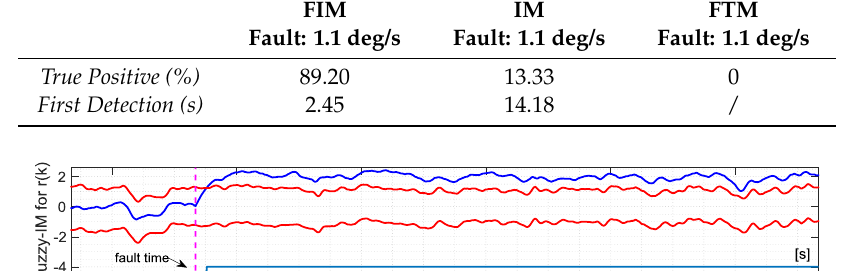
indicated by the vertical dashed lines.